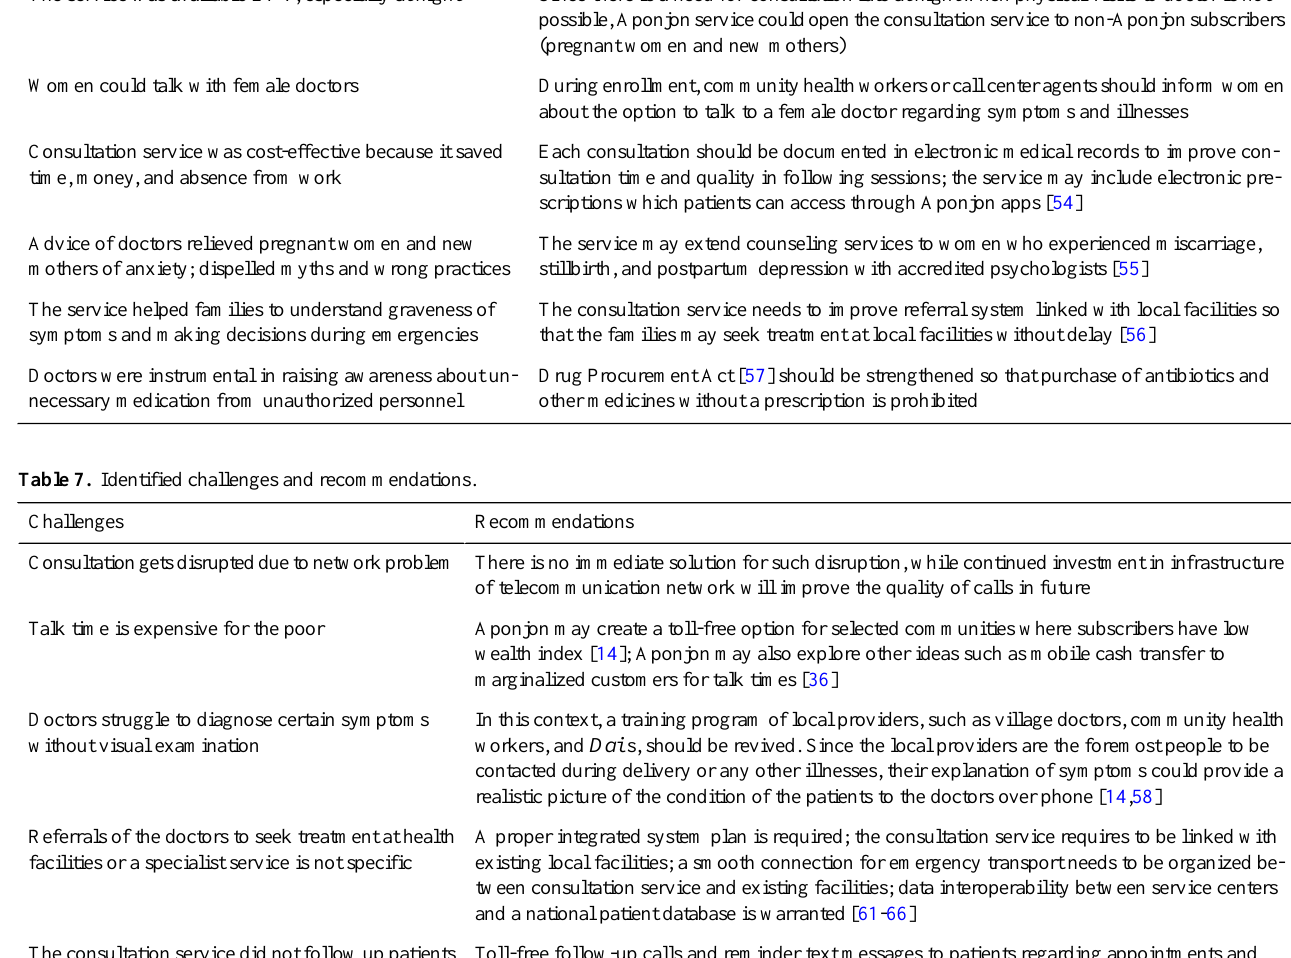
Way forwardBenefits